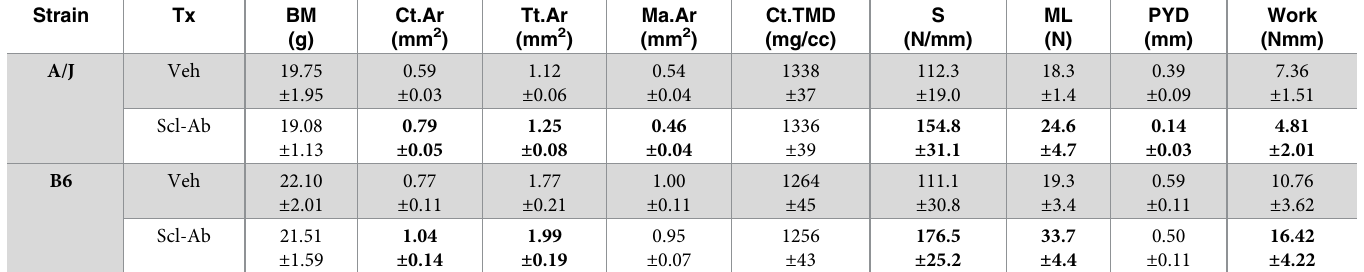
Table 1. Final body mass at study completion with unadjusted means and standard deviations for morphological and mechanical traits of Scl-Ab and vehicle treated femurs from A/J and B6 inbred mice. Significant differences prior to body mass adjustment ( p < 0.05) between vehicle and treated mice within a strain are indi- cated in bold .